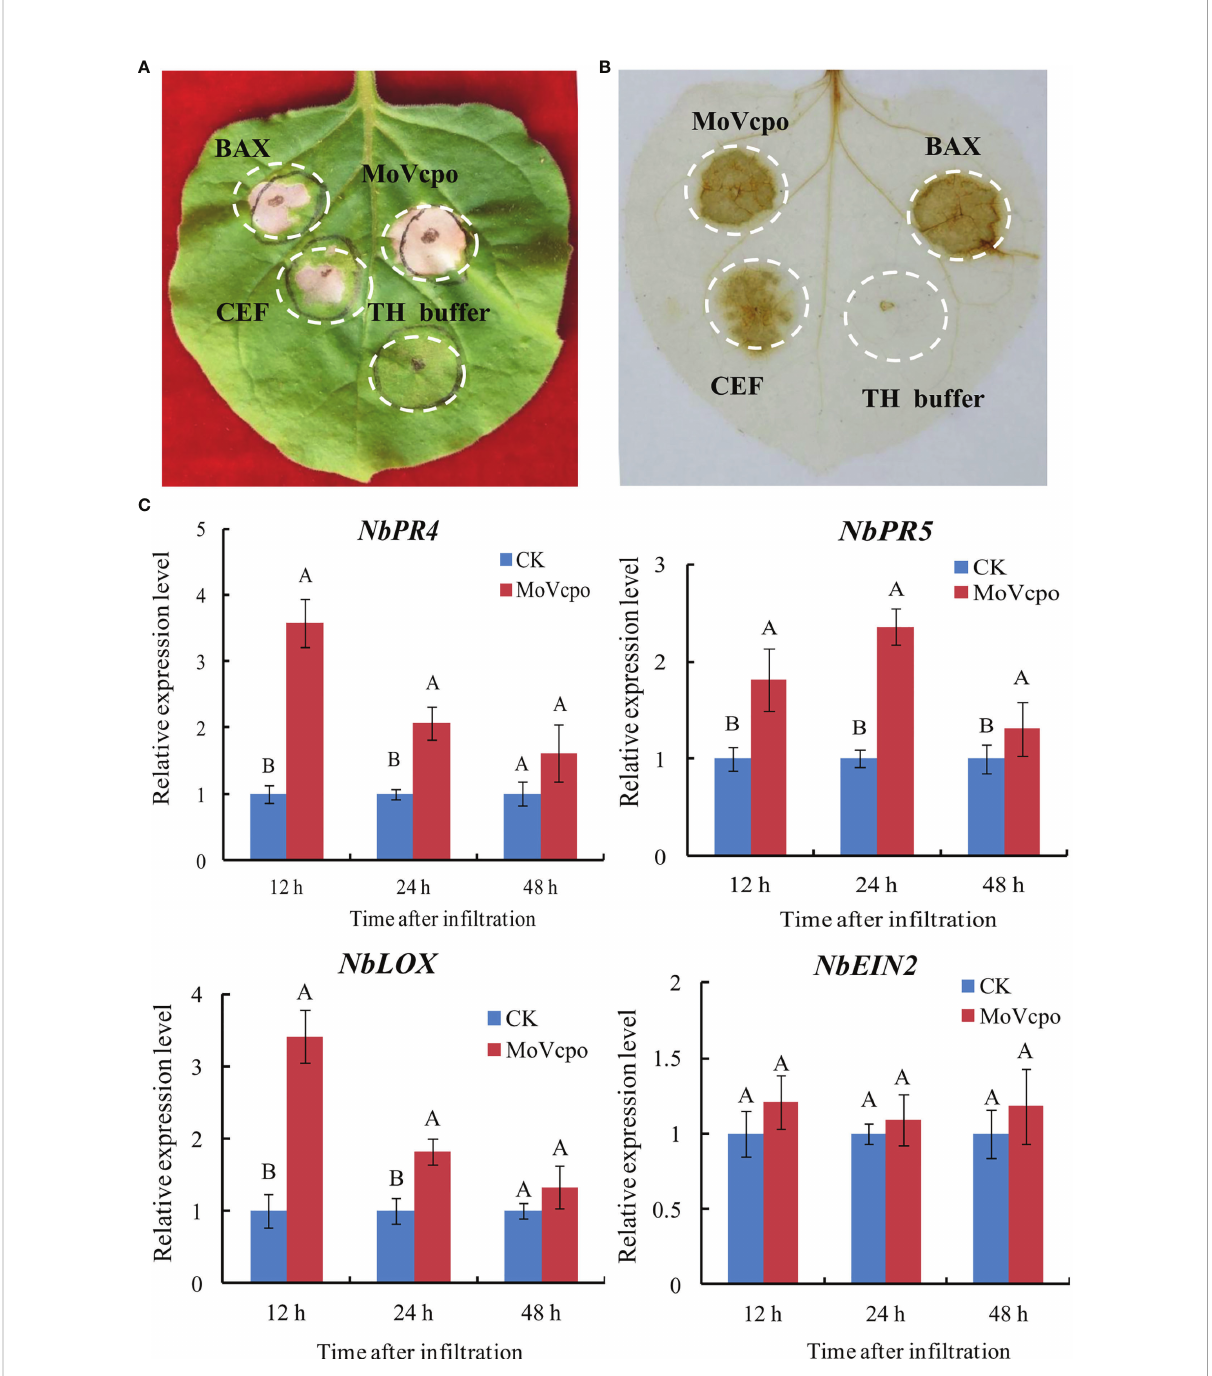
FIGURE 2 MoVcpo induces plant immune responses in Nicotiana benthamiana. (A) MoVcpo induced the hypersensitive reaction in N. benthamiana leaves. Tobacco leaves were in fi ltrated with CEF (crude elicitor fraction, 50 m g/mL), MoVcpo (50 m g/mL), A . tumefaciens expressing BAX (as positive control) or TH buffer (as negative control). The leaves were photographed 3-4 d after in fi ltration. (B) Reactive oxygen species were detected by DAB staining. (C) RT-qPCR analysis of four defense-related genes after in fi ltration with MoVcpo solution (50 m g/mL). Values are the means ( ± SE) based on three independent experiments and bars indicate standard deviations. Letters indicate statistical signi fi cance ( p < 0.05) using Duncan ’ s new multiple range